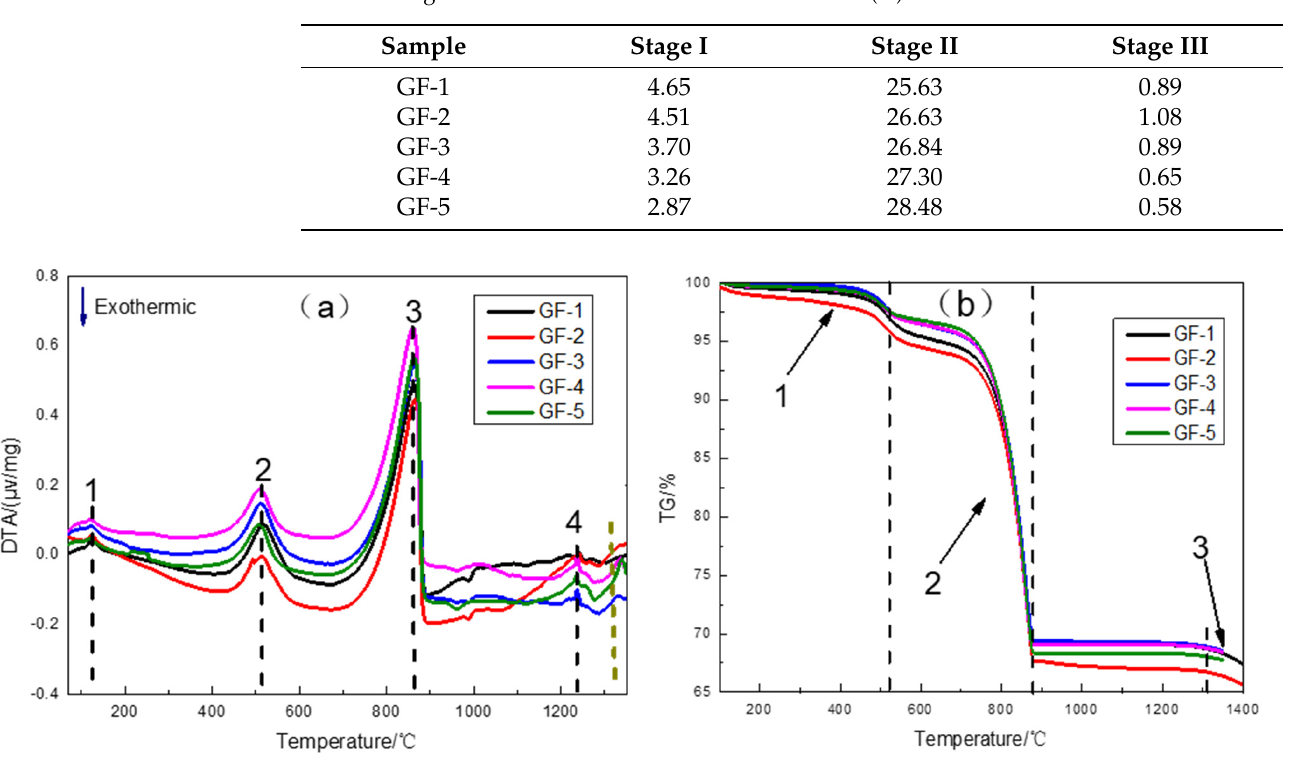
Table 6. Weight loss of HBSC raw materials in TG curves (%).